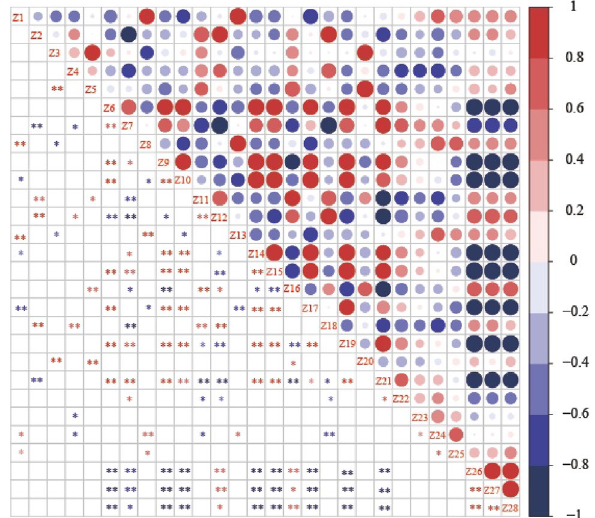
Figure 10. Correlation analysis of dominant genera and straw degradation characteristics at different culture stages. Z1: Pseudomonas , Z2: Trichococcus , Z3: Flavobacterium , Z4: Acinetobacter , Z5: Azospirillum , Z6: